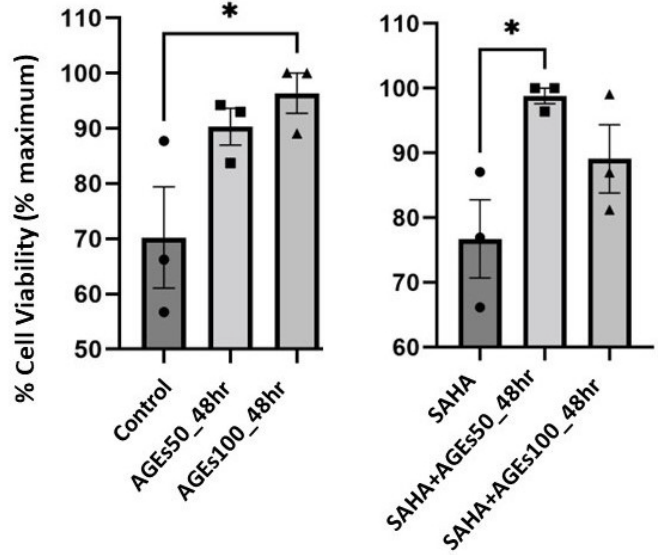
Figure 8. AGEs, not SAHA, IncreasedProliferation in Primary Mouse Keratinocytes. Mouse primary keratinocytes were treated with BioVision AGEs in the presence of absence of 1 µ M SAHA for 48 h. Cell proliferation was measured using MTT assays. The data are expressed as % maximal response and represent the means ± SEM from three independent experiments; symbols represent individual experiments. * p < 0.05 versus the control value.